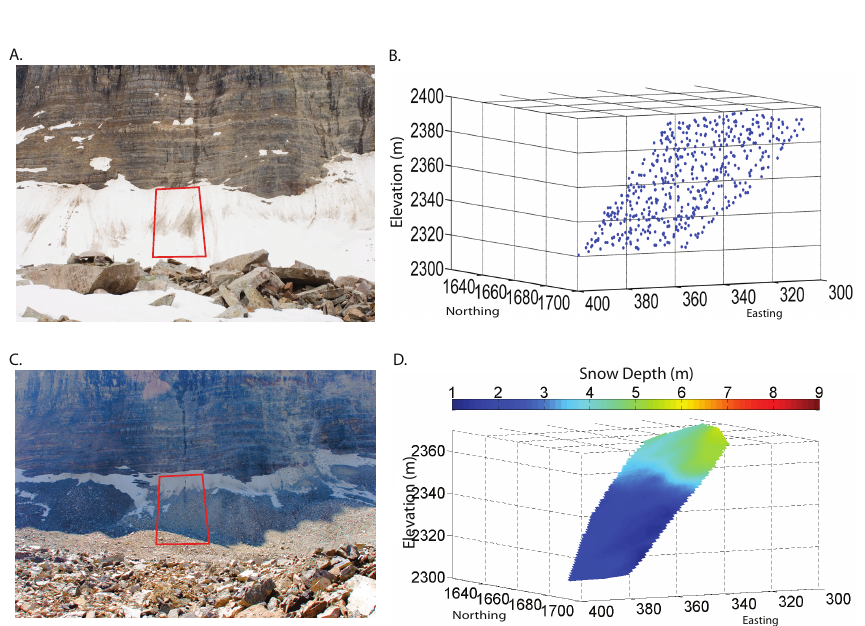
Fig. 6. Upper talus slope (A) snow covered (20 June 2008), (B) distribution of laser points (June), (C) snow free (29 September 2008), (D) laser snow